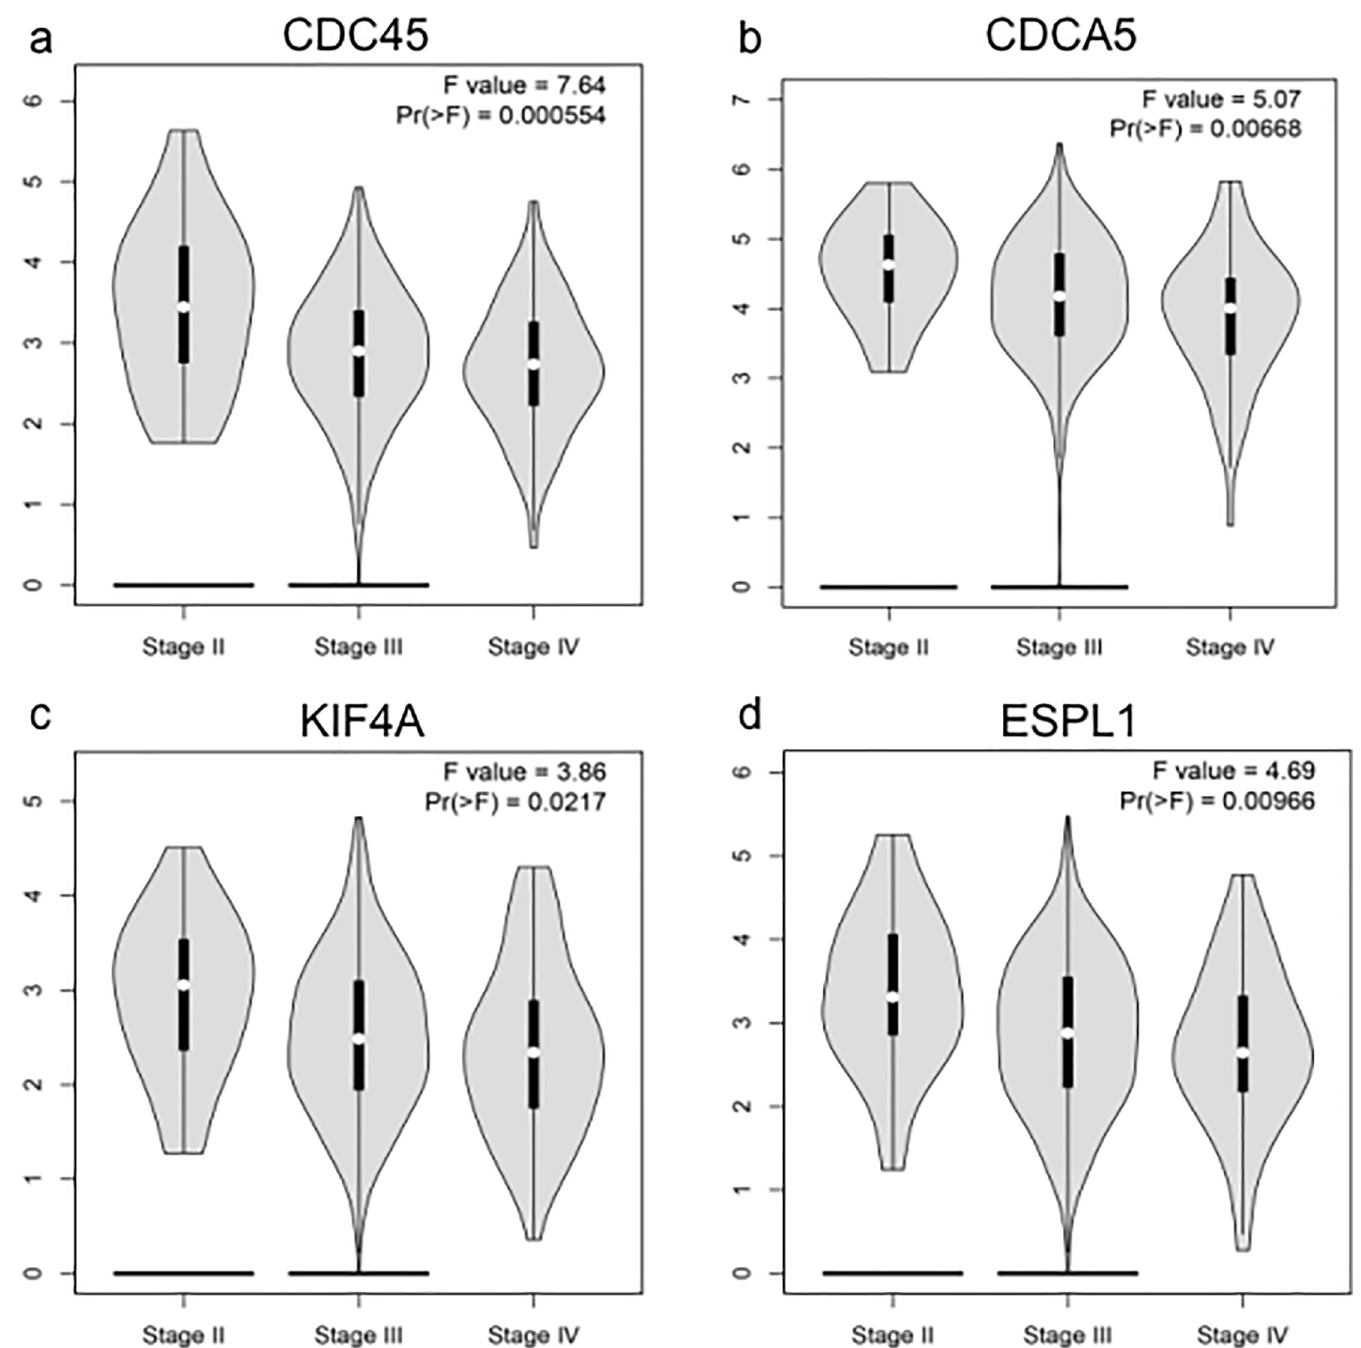
Fig 6. The expression level of hub genes in EOC tissues at different stages. To further verify the expression level of the hub genes in EOC tissues at different stages, the hub genes were analyzed by the GEPIA2 online database. ANOVA was performed to assess the statistical significance of the variations. Pr ( > F) < 0.05 was considered statistically significant. According to the result, there were significant variations in the expression levels of CDC45, CDCA5, KIF4A, and ESPL1 (a-d). The overall trends indicated that the expression of these four genes decreased gradually with the continuous progression of OC.